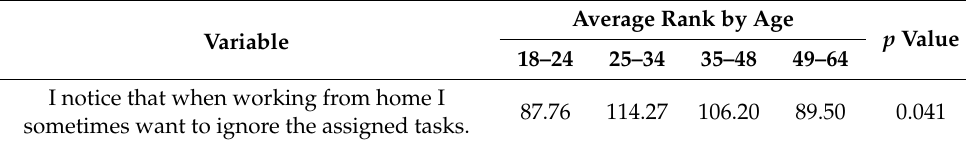
Average Rank by